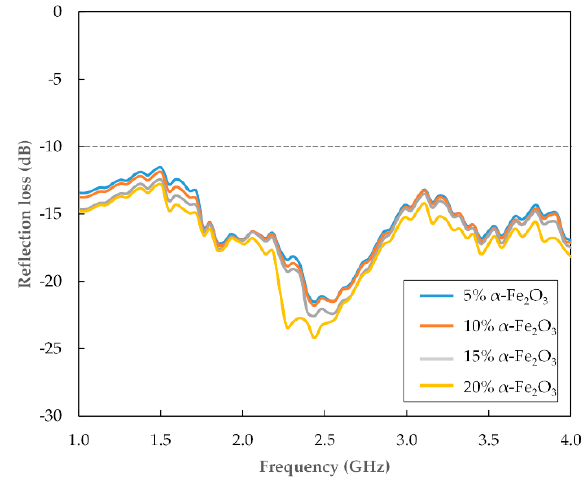
Figure 9. Variation in reflection loss with for the recycled α -Fe 2 O 3 / OPEFB / PCL nanocomposites. Table 3. Variation in reflection loss (dB) for recycled α -Fe 2 O 3 / OPEFB / PCL nanocomposites. α -Fe 2 O 3 (wt.%) 1 GHz 2.4 GHz